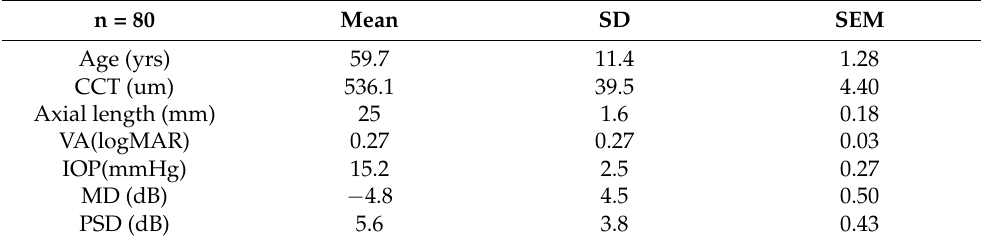
Table 1. Baseline characteristics of normal-tension glaucoma patients in this study.